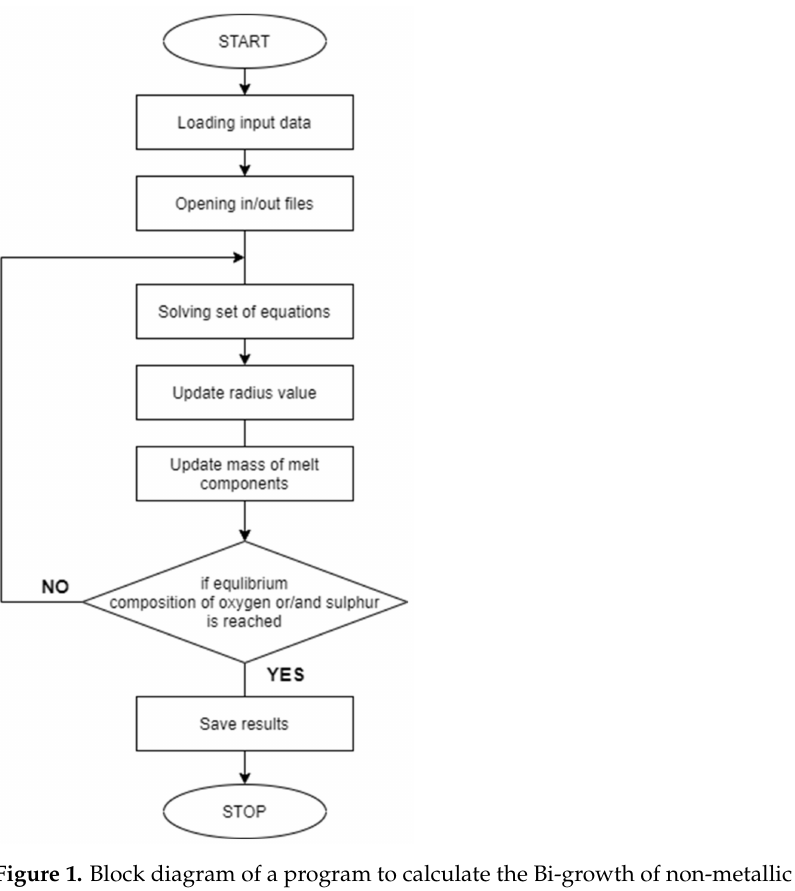
Figure 1. Block diagram of a program to calculate the Bi-growth of non-metallic inclusions during ladle refining of